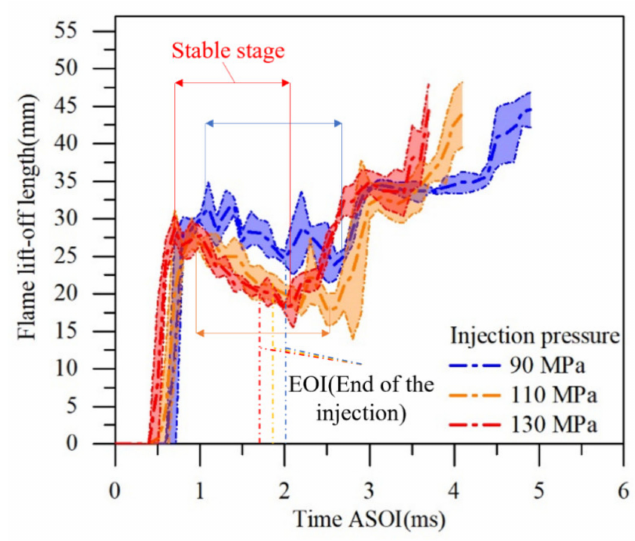
Figure 13. Flame upstream and lift-o ff length.